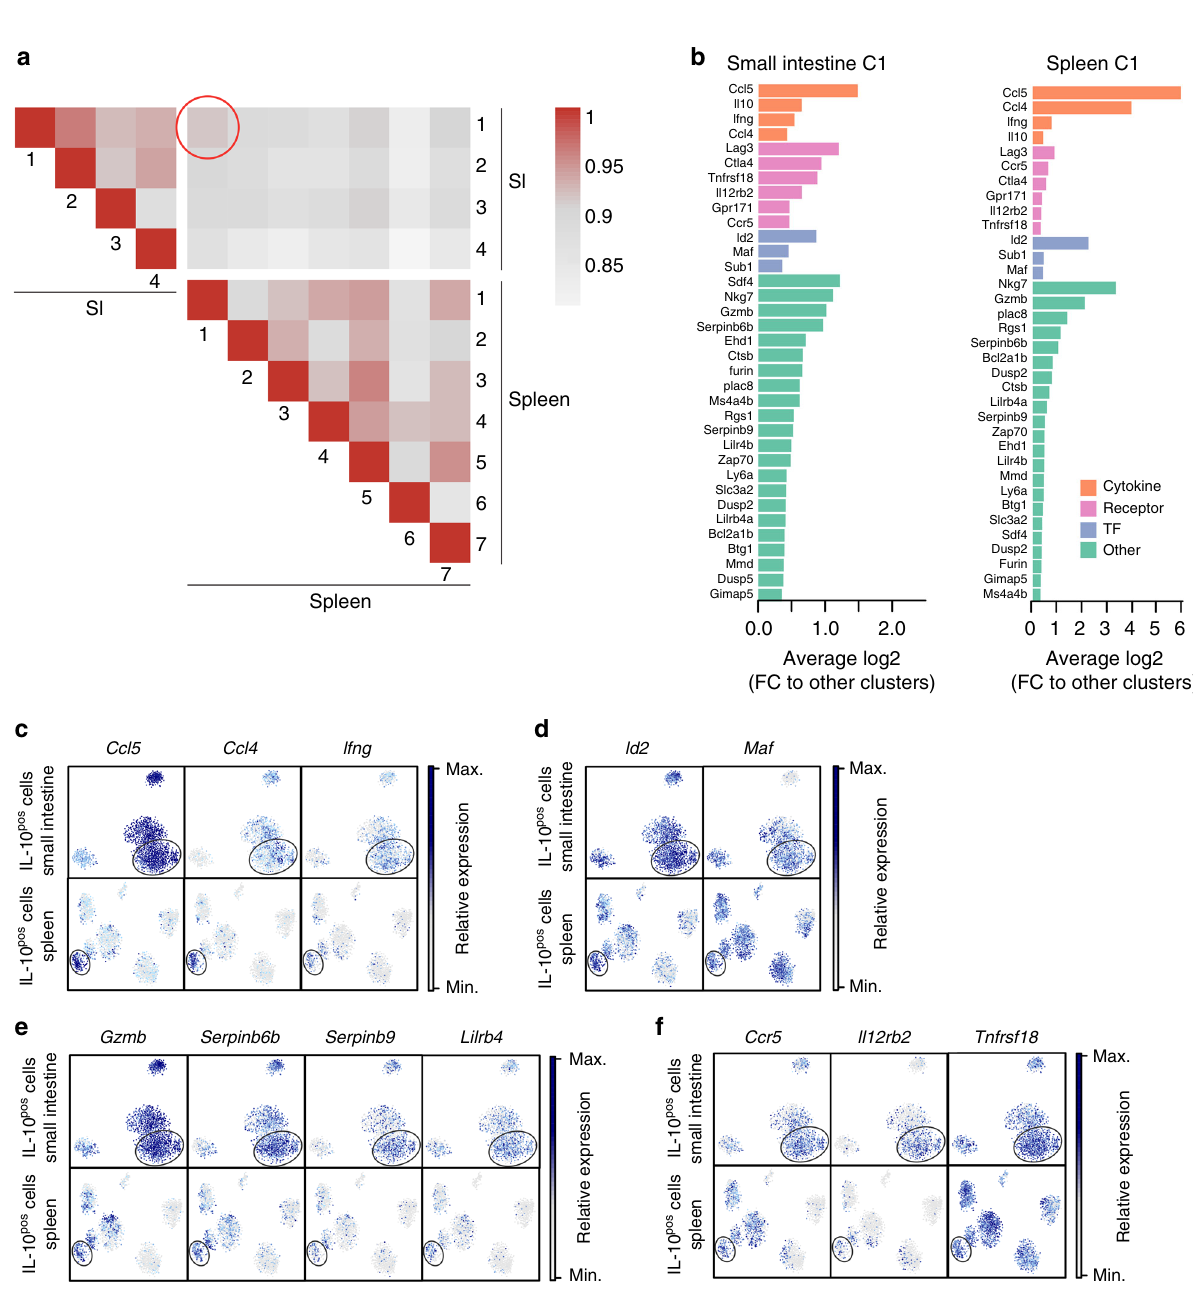
Fig. 2 Splenic IL-10-producing CD4 + T cells contain a regulatory cluster. a Spearman correlation coef fi cient between each cluster from small intestine and spleen. b Fold change analysis of genes enriched in indicated clusters compared to other clusters that were amongst the 100 most enriched genes. c Expression of indicated genes encoding cytokines and chemokines. d Expression of indicated genes encoding transcription factors. e Expression of indicated genes encoding other factors. f Expression of indicated genes encoding surface